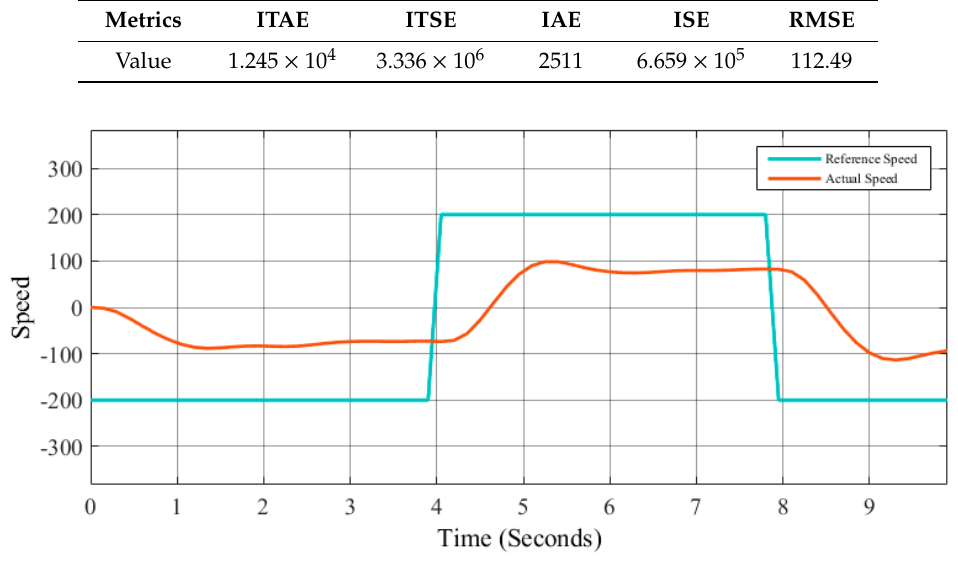
Figure 22. Simulation for FLC.